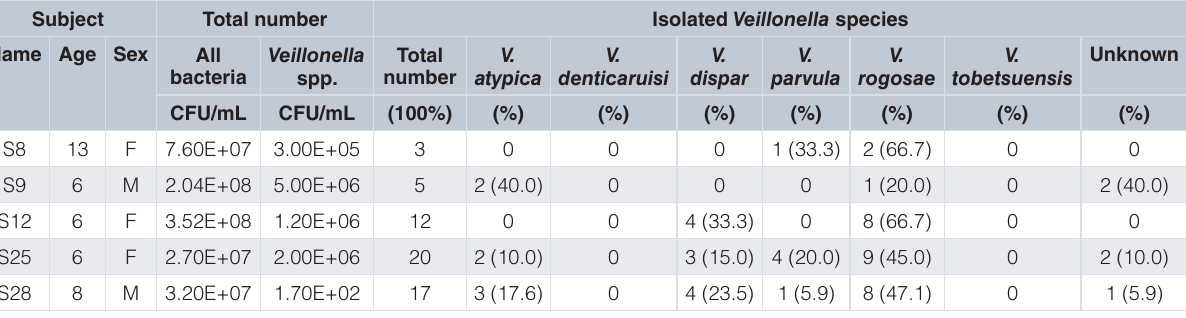
Table 1. Ratio of the number of isolates of each species to the total number of Veillonella isolate in saliva from the good oral hygiene group. The colony-forming units (CFU) of all anaerobic bacteria on brain heart infusion agar and Veillonella strains on Veillonella agar (detection limit <0.1% of the total count). The total of Veillonella isolates identified by the Veillonella genus-specific PCR primer. Individual species as a percentage of the number of isolates identified by one-step PCR with the species-specific primer sets for each subject ( n = 5) from saliva of the good oral hygiene group.